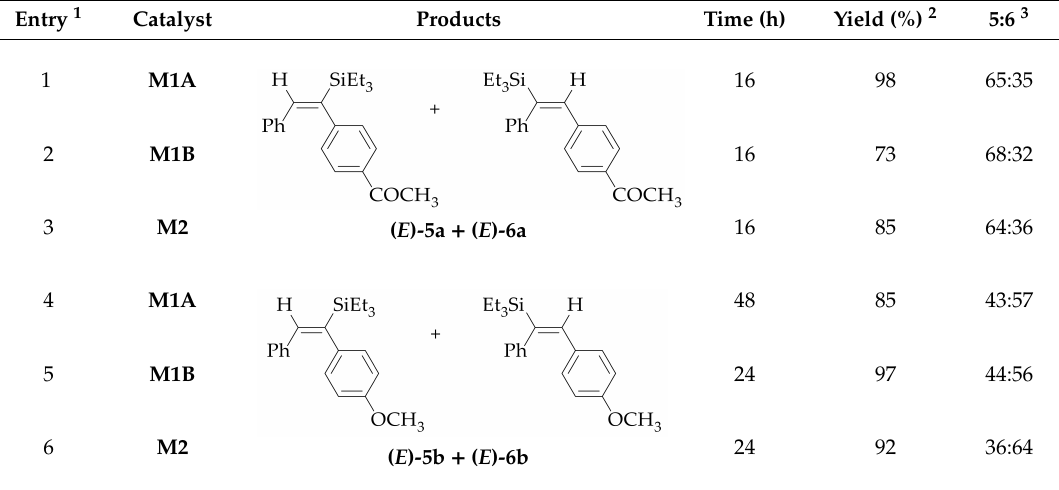
Table 4. Hydrosilylation of unsymmetric diaryl alkynes under catalysis by Rh